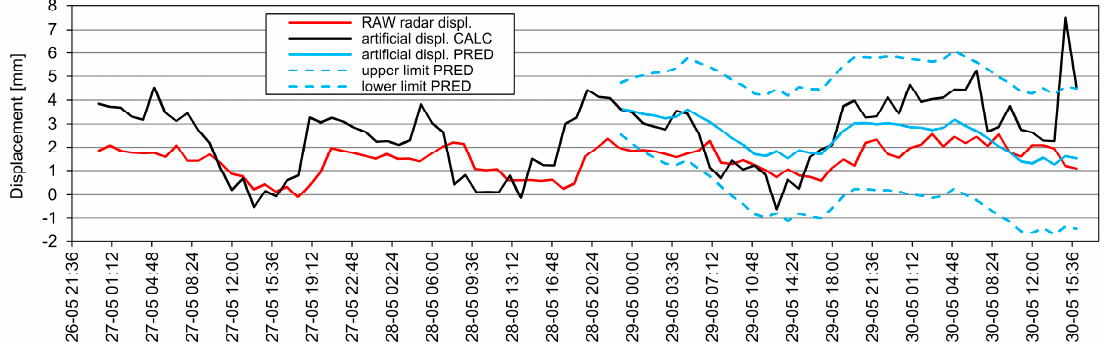
Figure 21. Comparison of the raw radar displacements (red), calculated apparent displacements (black) and the predicted apparent displacements (blue).